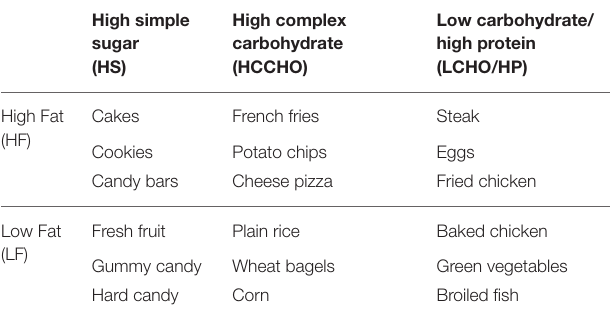
TABLE 1 | Example foods in each category of the Macronutrient Picture System (MaPS) and the Geiselman Food Preference Questionnaire (FPQ). High simple